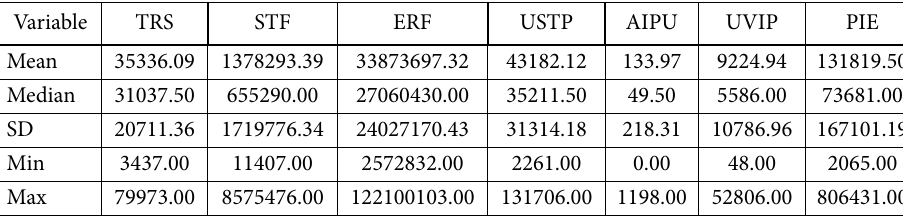
Table 3. Descriptive statistics of inputs and